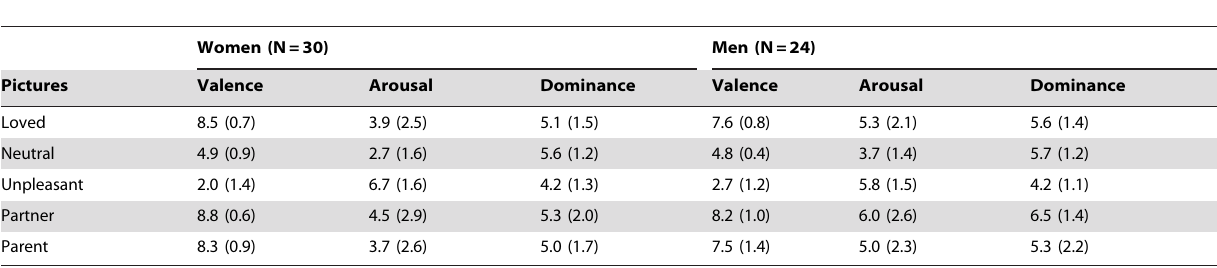
Table 1. Subjective ratings of Valence, Arousal, and Dominance for the faces.